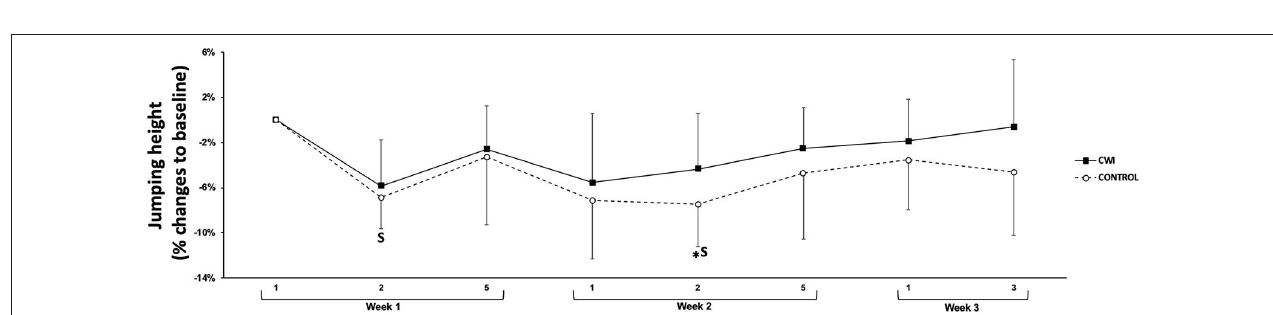
between groups for any training day ( p = 0.244 to p = 1.000).